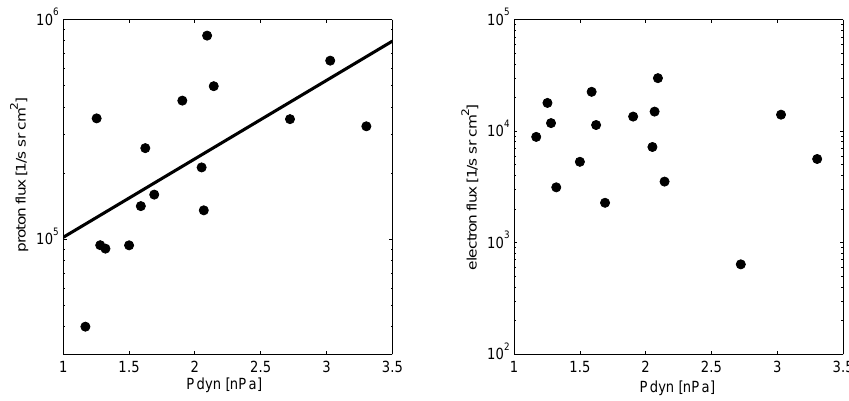
Fig. 11. Energetic particle fluxes in the HLPS as a function of solar wind dynamic pressure. Left: protons, right: electrons.